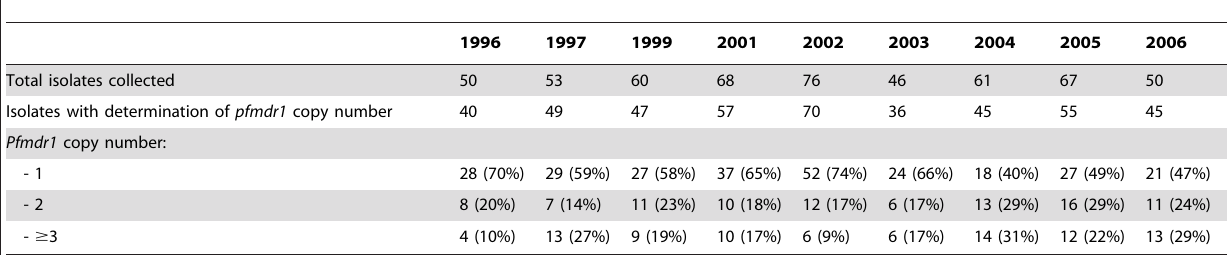
Table 6. Pfmdr1 copy number in parasite isolates collected in patients with primary uncomplicated P. falciparum